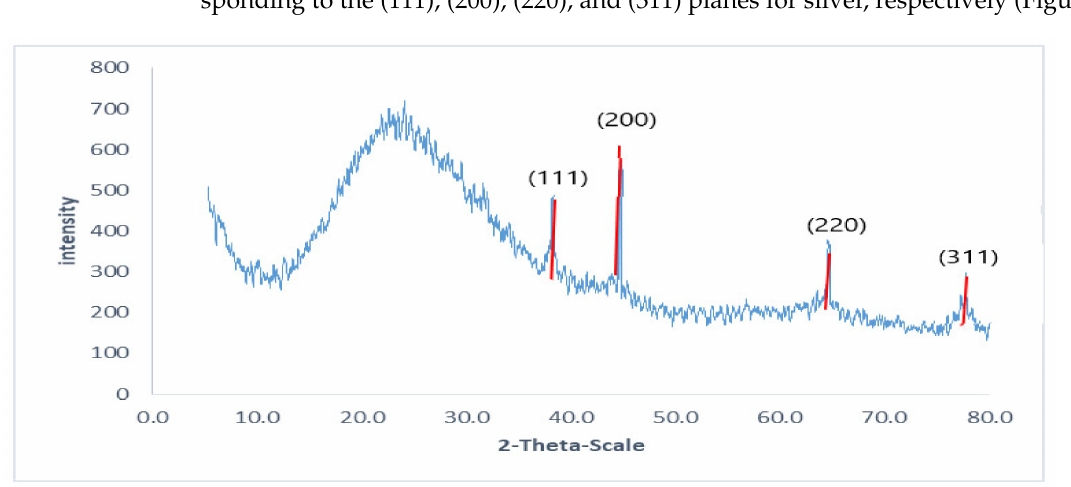
Figure 6. X-ray diffraction pattern of the biosynthesized AgNPs using GTLE.